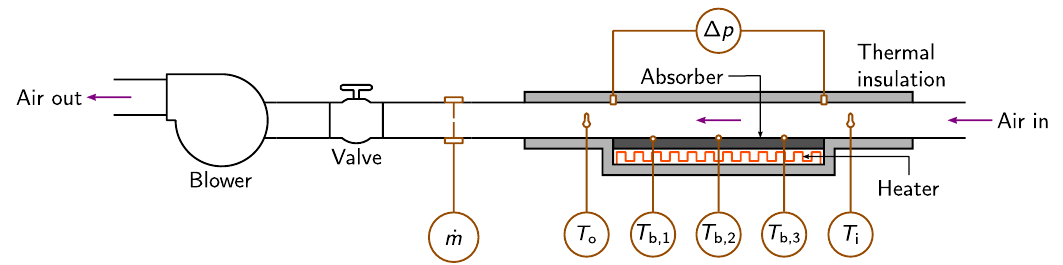
Figure 4. Experimental set-up configuration for absorber